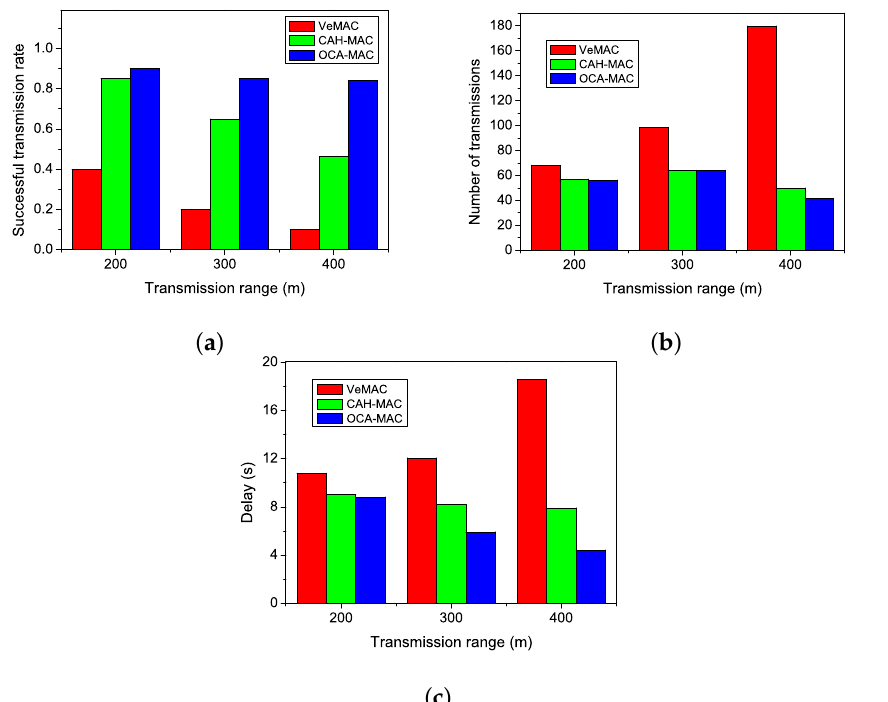
Figure 7. Influence of transmission range on the performance. ( a ) Successful transmission rate. ( b ) Number of transmissions. ( c )